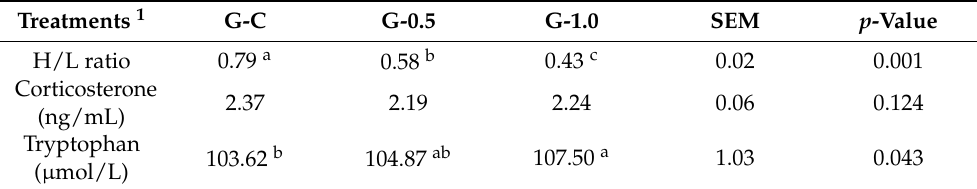
Table 3. Effect of dietary synbiotic supplementation on Heterophil/Lymphocyte ratio, plasma concentrations of corticosterone and tryptophan of the heat-stressed broiler chickens from 15 to 42